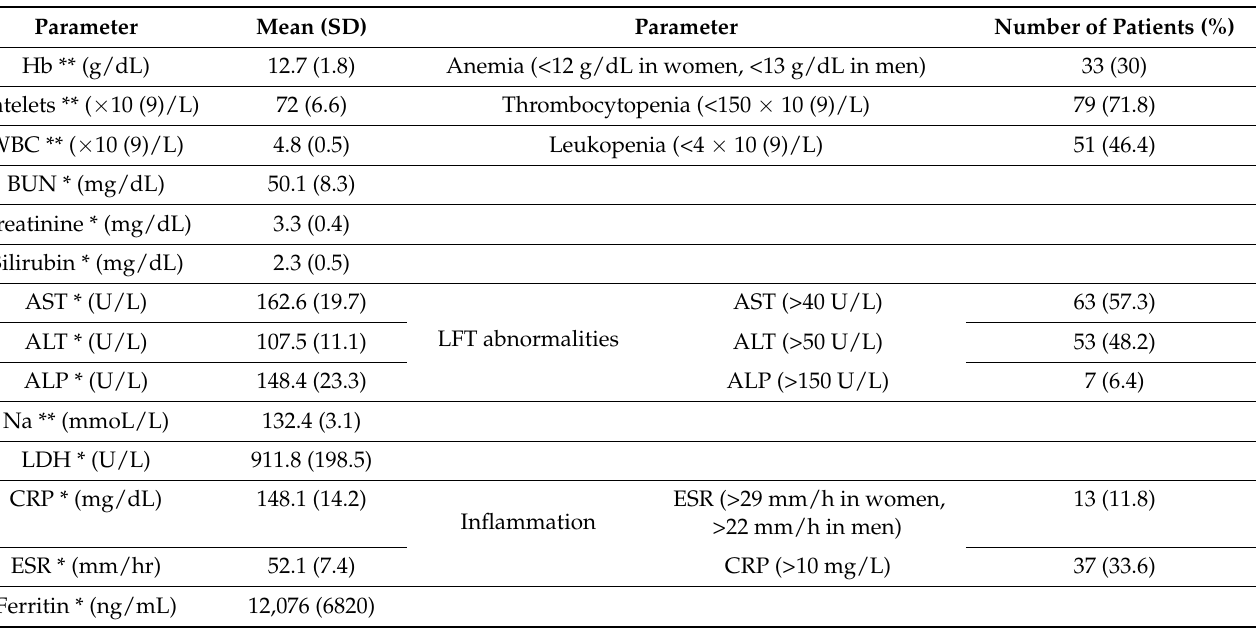
Table 3. Laboratory investigations and laboratory abnormalities reported in patients diagnosed with